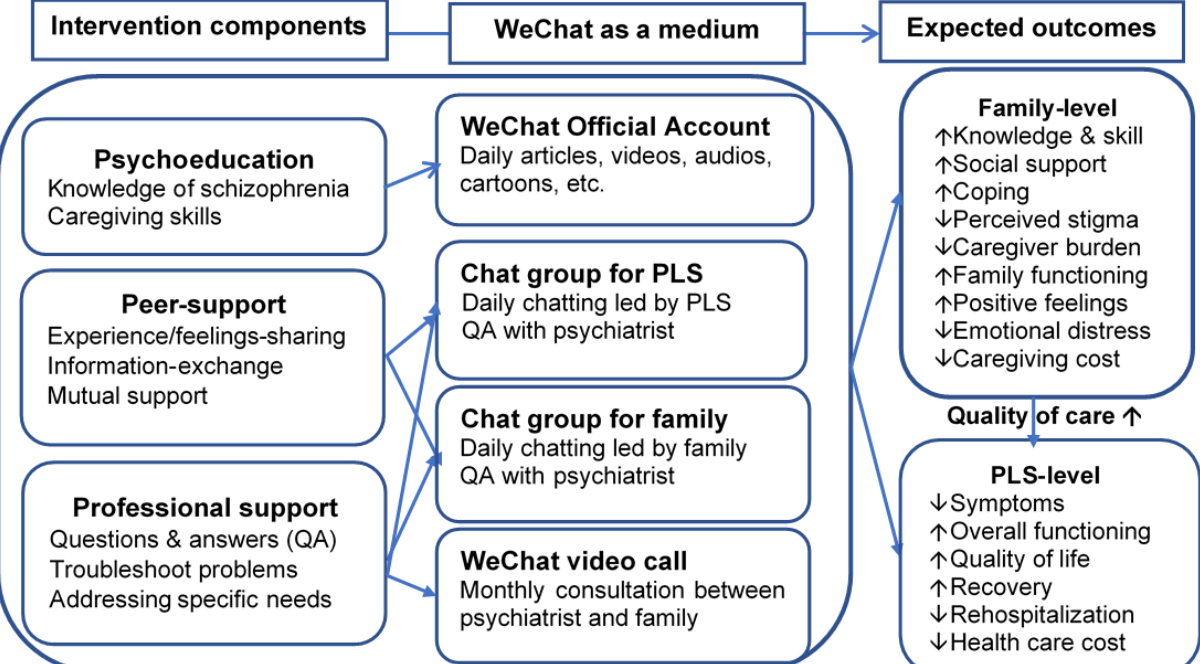
Figure 1. Theoretical framework of the proposed study. PLS: people living with